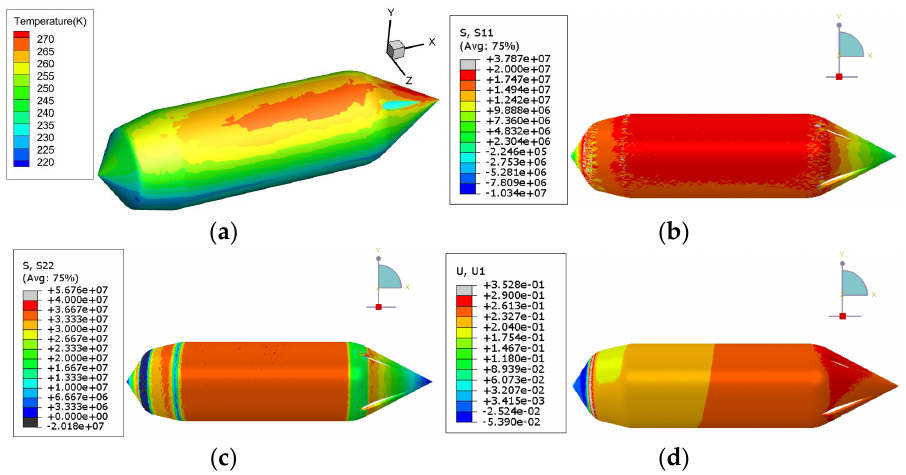
Figure 8. Simulation results at 12:00 p.m. ( a ) Temperature distribution at 12:00 p.m. ( b ) S11 stresses at 12:00 p.m. (units: Pa) ( c ) S22 stresses at 12:00 p.m. (units: Pa) ( d ) U1 deformation at 12:00 p.m. (units: m).